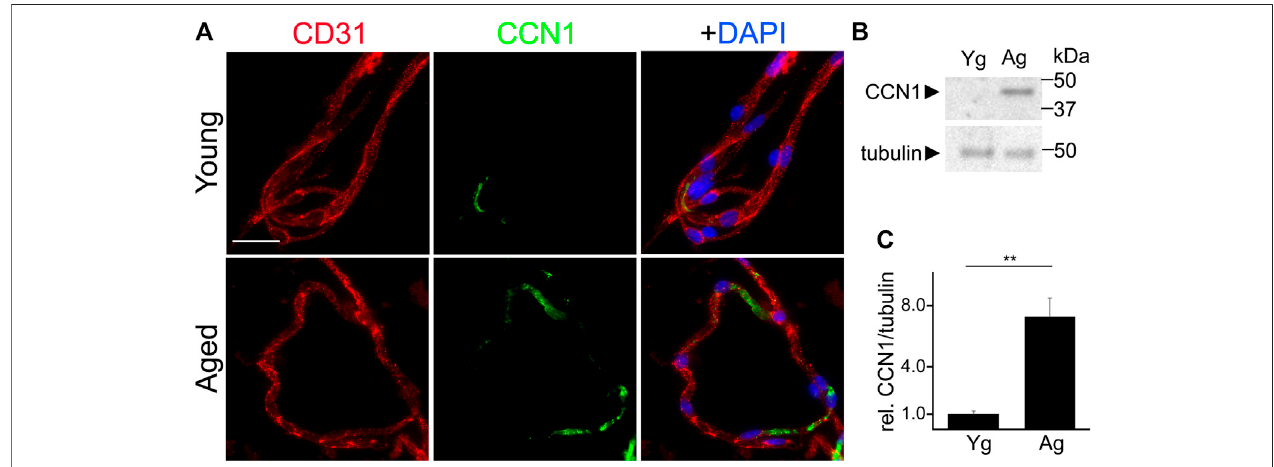
FIGURE 4 | CCN1 was upregulated in the microvessels isolated from the brains of aged mice and in cultured CEC isolated from aged mice compared with young mice. (A) Representative image of microvessels isolated from the brains of young (3 – 4 m/o) and aged (18 – 20 m/o) female mice, and stained with antibodies against the endothelialmarkerCD31,withantibodiesagainstCCN1,andwiththenuclearHoechstdye(DAPIchannel).Scalebar,25 µm. (B) CECwereisolatedfromyoung(3-4-m/ o) and aged (18 – 20 m/o) female mice, cultured and maintained until 100% con fl uence. Cells were collected and lysed and processed for gel electrophoresis and analyzed for Western blotting. (C) Band intensities of CCN1 relative to tubulin. t -test, ** p -value < 0.0019. Data were obtained from four mice per